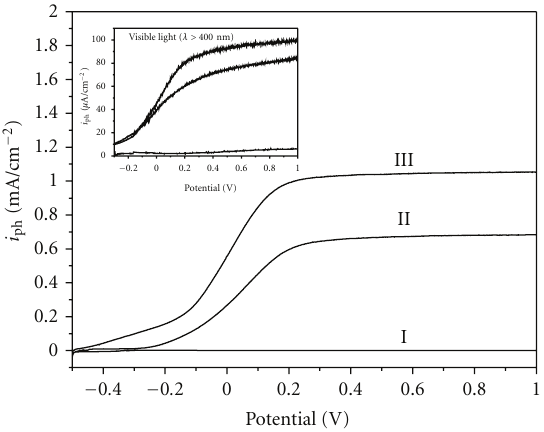
Figure 3: Photocurrent-potential curves obtained for TiO 2 nan- otube arrays electrode under dark conditions (curve I) and for 0.1molL − 1 Na 2 SO 4 (curve II) and 0.1 molL − 1 NaCl (curve III) under illumination ( complete solar spectrum). The inset shows the corresponding visible light response of the electrode ( λ > 400 nm). Scan rate = 10 mVs − 1 , pH = 6 . 0.